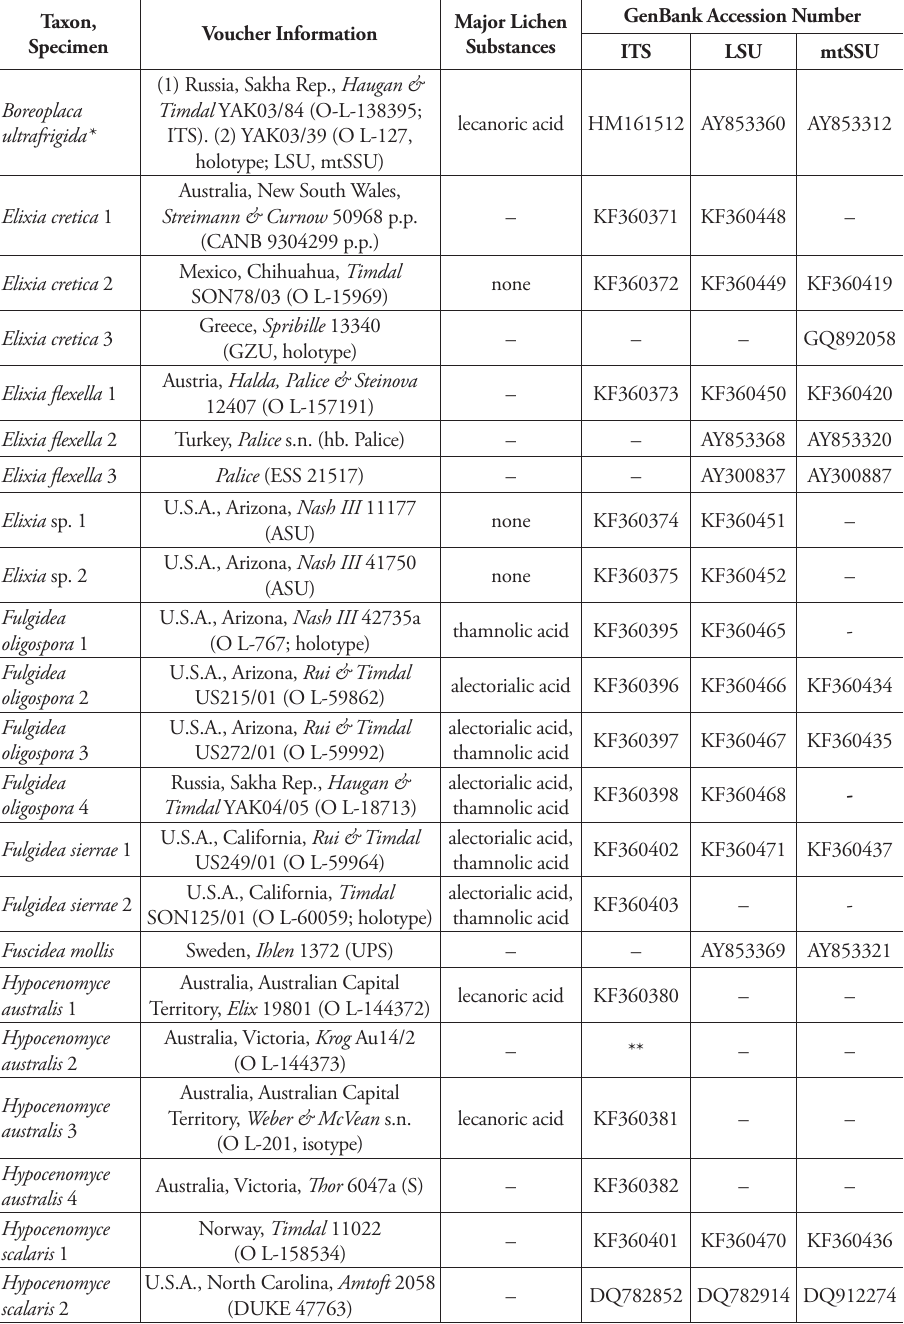
Table 1. Specimens used in this study with voucher information, major lichen substances, and GenBank accession